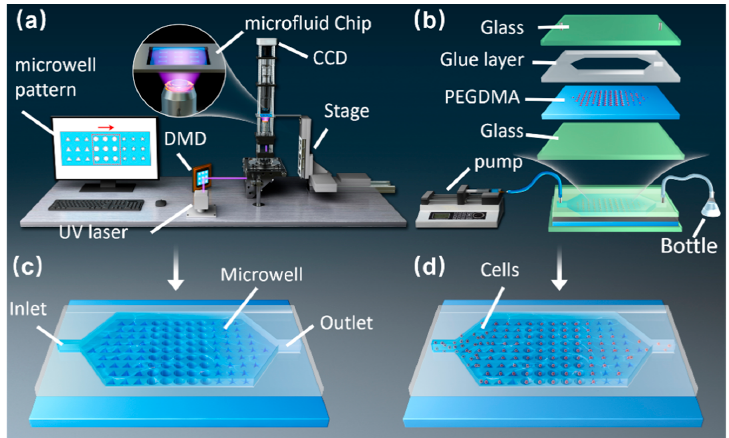
Figure 1. ( a ) Schematic of optofluidic maskless lithography system. ( b ) Composition and assembly of the chip. ( c ) System-based fabrication of microwell arrays. ( d ) Diagram of cell injection and